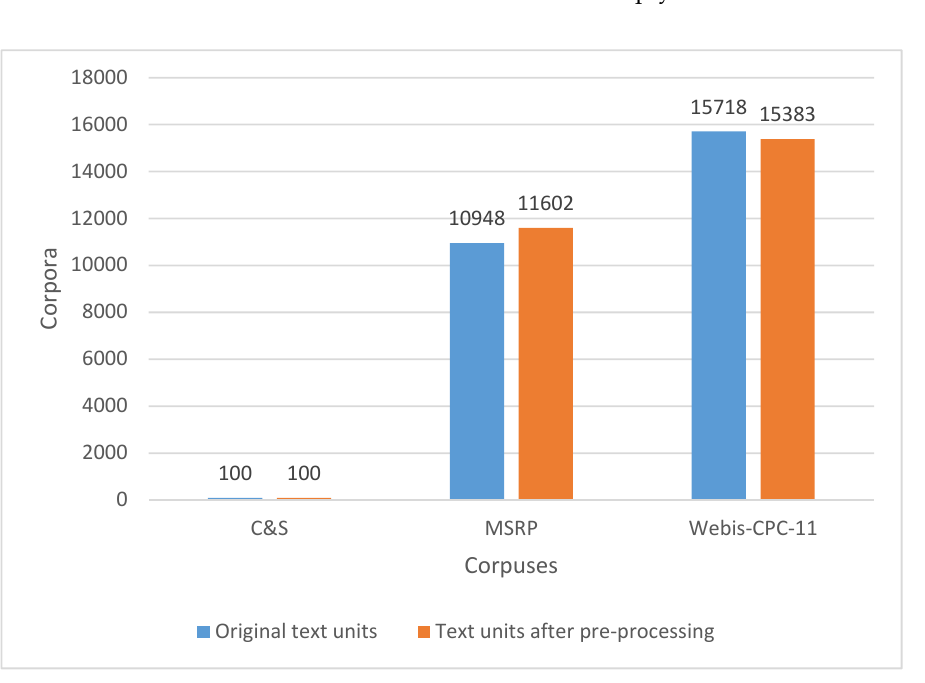
Figure 1. Number of text units before and after pre-processing.